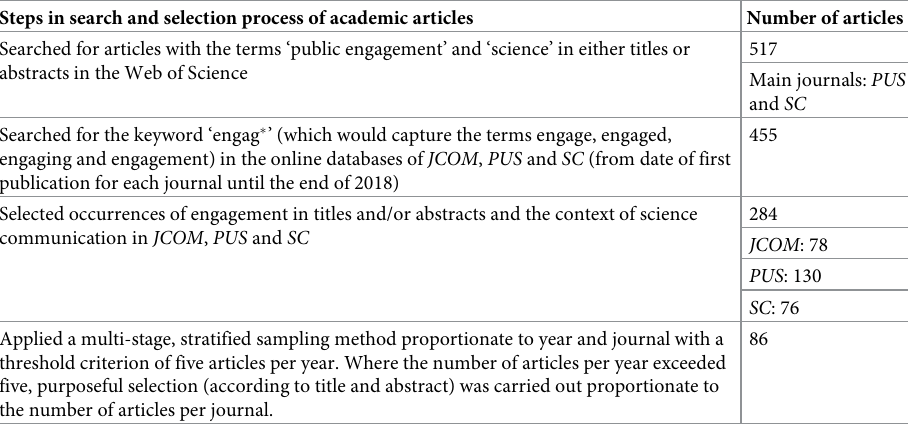
Table 1. Search and selection process of academic articles.